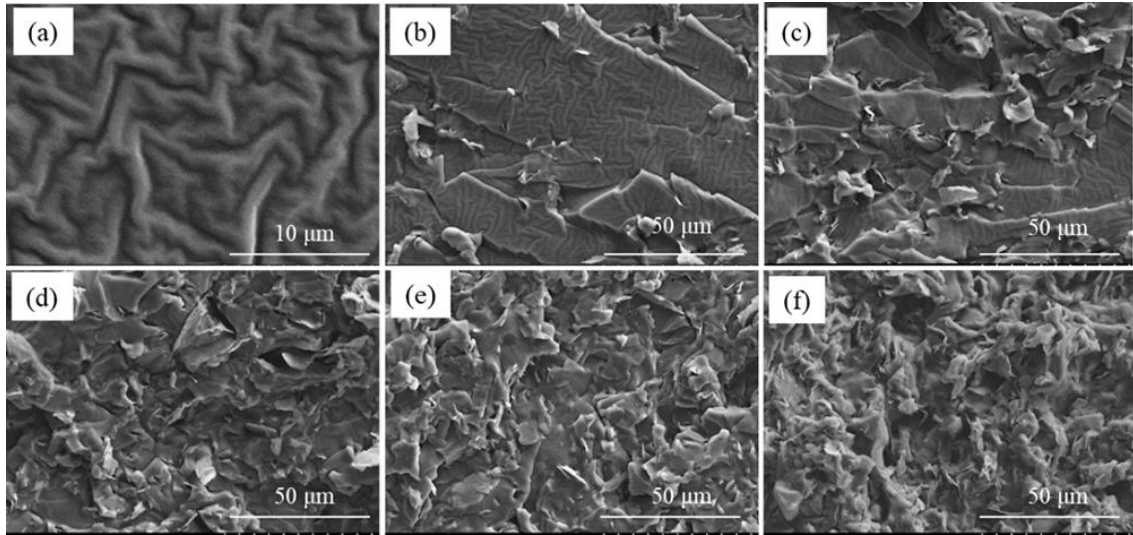
Figure 8. SEM images of BN − MG/SR with different BN − MG loadings: ( a ) 0 wt.%, ( b ) 1 wt.%, ( c ) 3 wt.%, ( d ) 5 wt.%, ( e ) 7 wt.%, and ( f ) 10 wt.%.